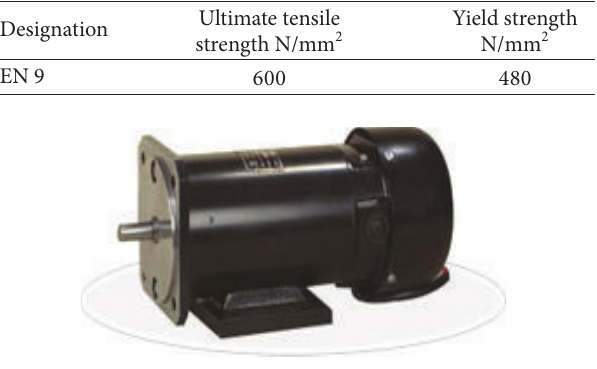
Figure 3: Permanent magnet DC